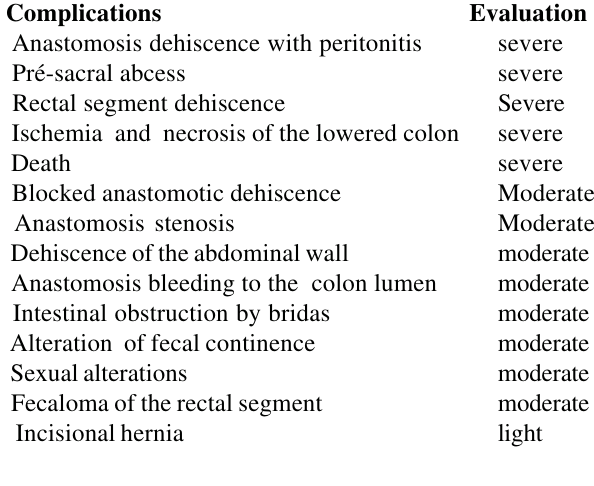
Post-surgery complications